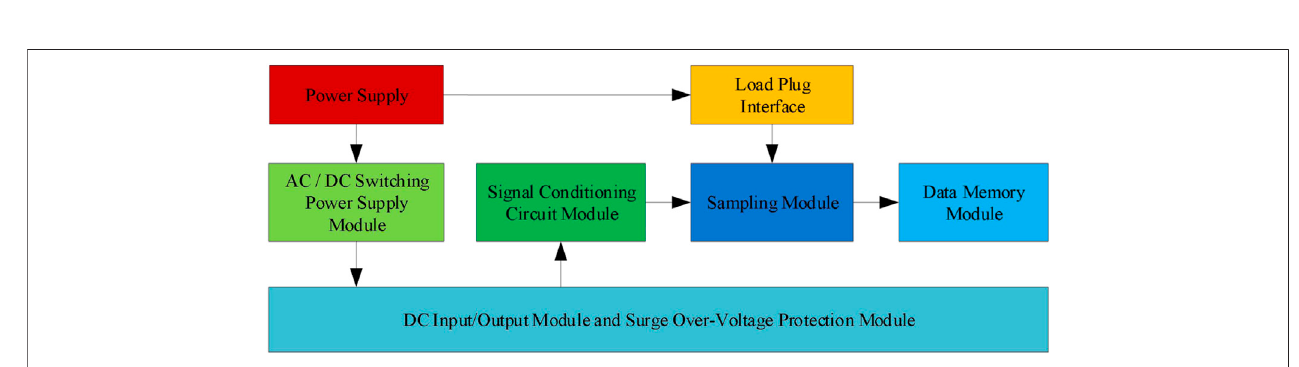
FIGURE 10 | Schematic diagram of the data acquiring device.